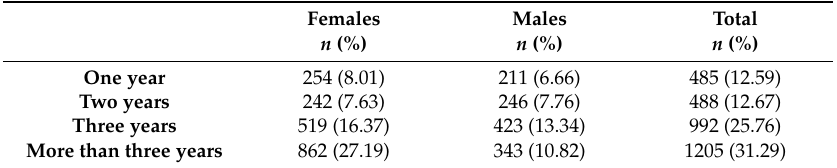
Table 2. Distribution of the sample across planning period for owning a practice and sex.